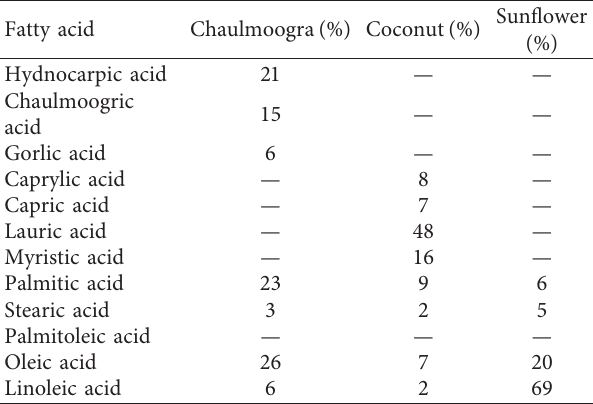
Table 1: Fatty acid composition of chaulmoogra oil, coconut oil, and sunflower oil [26,